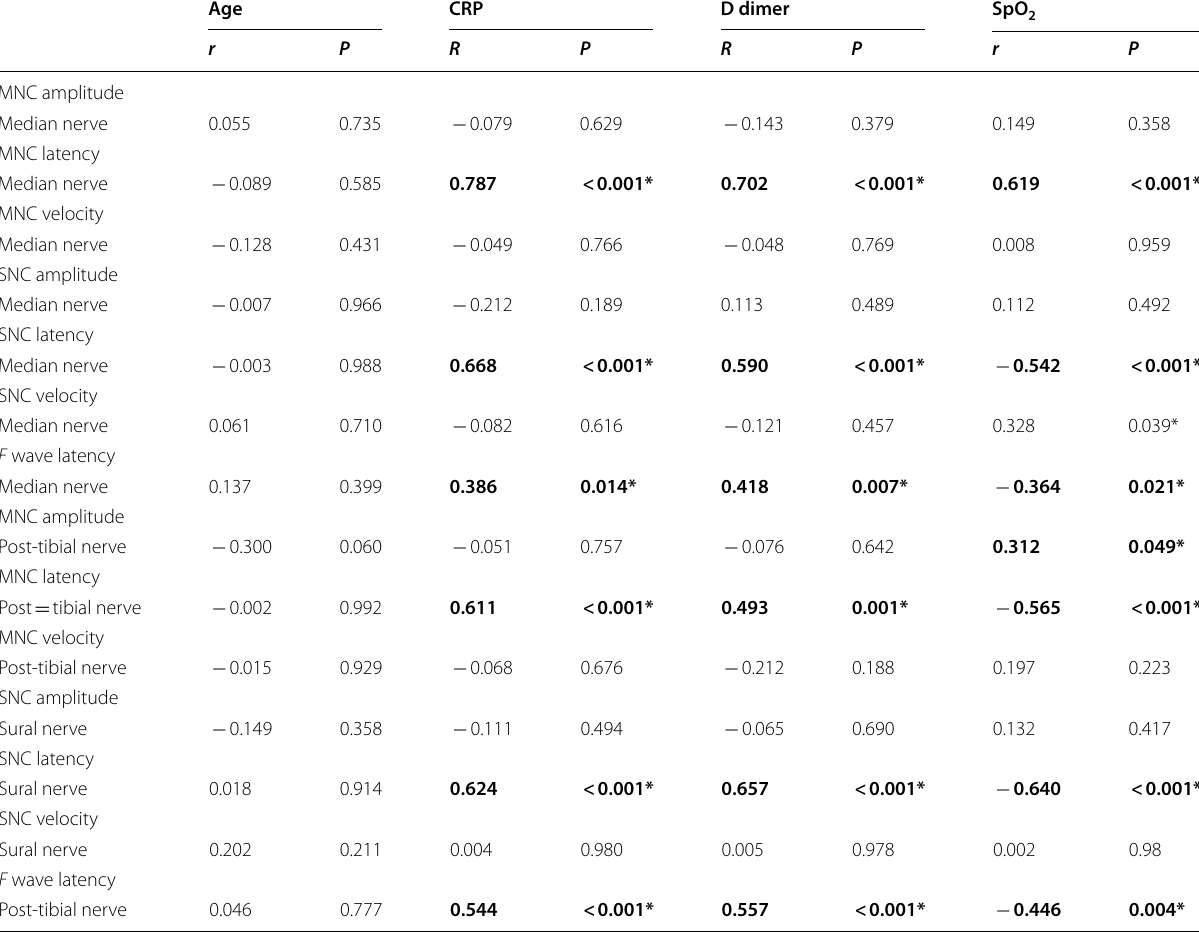
with nerve conduction study results in COVID-19 cases 2